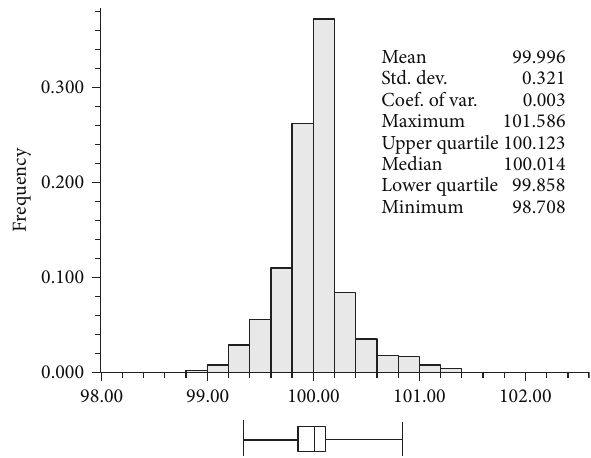
Figure 5: Histogram of the sums of the three fraction values at all grid locations predicted by cokriging without alr transformation. In the box plot below the histogram, outside whiskers correspond to the 95% probability intervals, inside boxes to the 50% probability intervals, and vertical lines in the box to the median value.